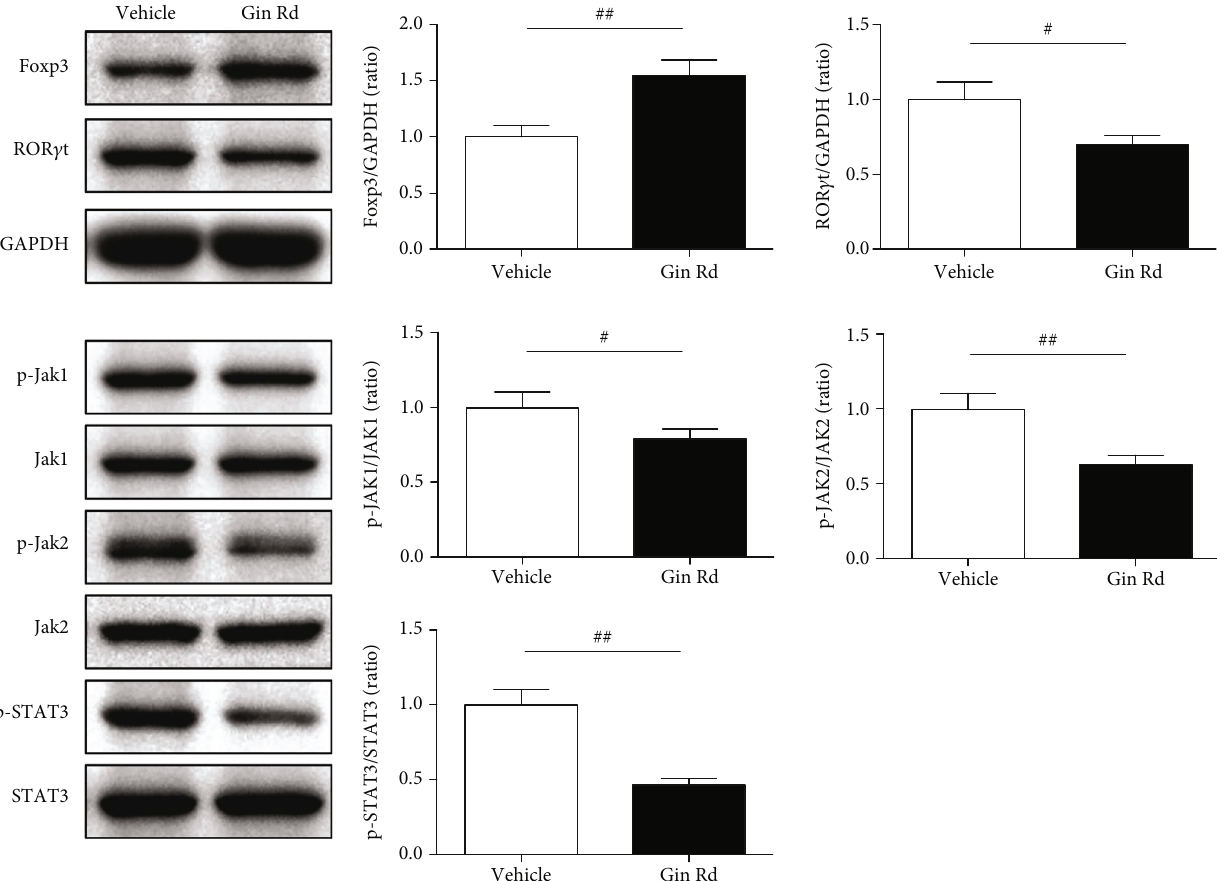
Figure 8: Relative protein expression of Foxp3, ROR γ t, p-JAK1, JAK1, p-JAK2, JAK2, p-STAT3, and STAT3 in splenocytes of EAE using western blotting assay ( n = 3 ). GAPDH was used as the internal control. Data are expressed as the mean ± SEM of each group ( n = 3 ). # P < 0 : 05 , ## P < 0 : 01 vs. vehicle group. Gin Rd: Ginsenoside